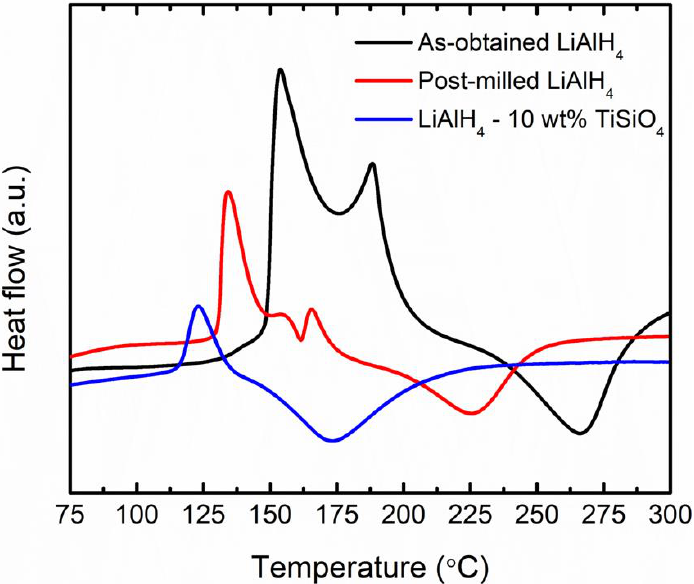
Figure 2. DSC data recorded at a rate of 15 °C/min for as-obtained LiAlH 4 , post-milled LiAlH 4 , and LiAlH 4 added with 10 wt% TiSiO 4 . Materials 2023 , 16 , x FOR PEER REVIEW The thermal event of LiAlH 4 is lowered from four to two after the addition of TiSiO 4 .